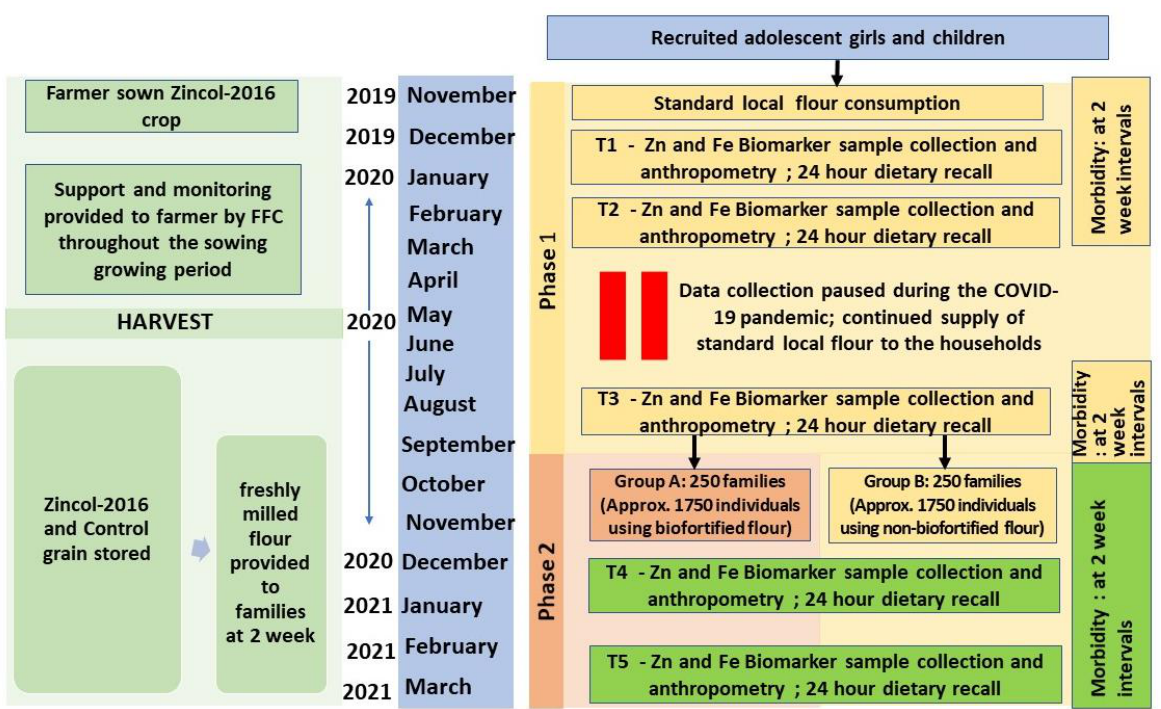
Figure 1. Schematic overview of the study design. FFC, Fauji Fertilizer Company; HH, Households; COVID-19, Coronavirus disease.